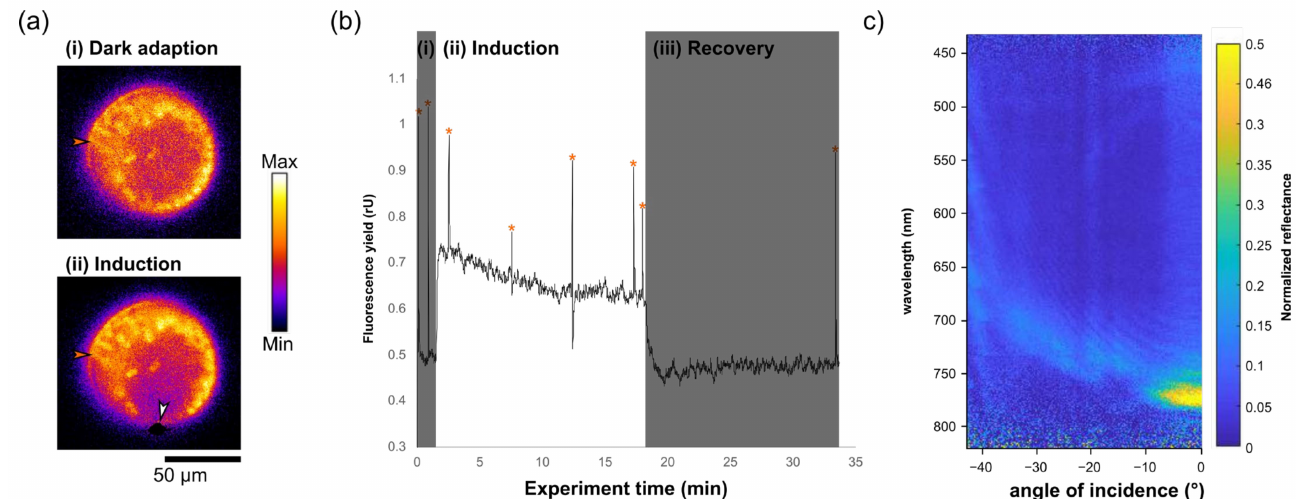
Figure 2. Chlorophyll fluorescence quenching and photosynthesis induction in diatoms (species Coscinodiscus granii ). Diatoms were left in the dark for 30 min prior to the start of the experiment. ( a ) Diatom in valve-view in (i) dark-adapted state in the absence of PAR light and (ii) during photosynthesis induction when illuminated with PAR light focused to ≈ 5 µ m spot (white arrow) onto the girdle. Chlorophyll fluorescence was recorded at low, non-PAR measuring light in a chloroplast distant to PAR illumination (orange arrow). Images are shown in false colour and altered brightness and contrast. ( b ) Graph of fluorescence yield (in relative units) versus time for the PAM excitation of the diatom. During the experiment, saturation pulses (orange asterisk above sharp peaks) were applied to estimate the oxidation potential of photosystem II. (i) shows dark adaptation (DA). Chlorophyll fluorescence rises upon illumination during (ii) the photosynthesis induction phase. Chlorophyll fluorescence decays to initial levels during (iii) recovery in the dark. Images and measurements were recorded at 100 × magnification. ( c ) Angularly resolved spectral data collected using the imaging spectrograph showing the reflectance of the girdle band of a live cell in in-plane direction, showing the photonic crystal-like optical mode, the general properties of which in biological material free girdles are described elsewhere